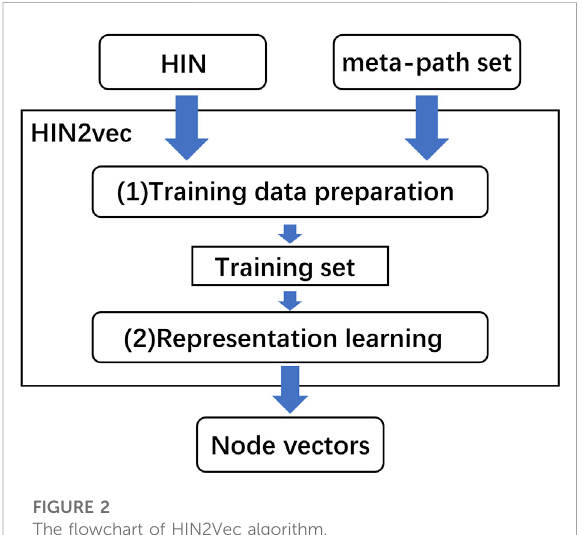
FIGURE 2 The fl owchart of HIN2Vec algorithm.